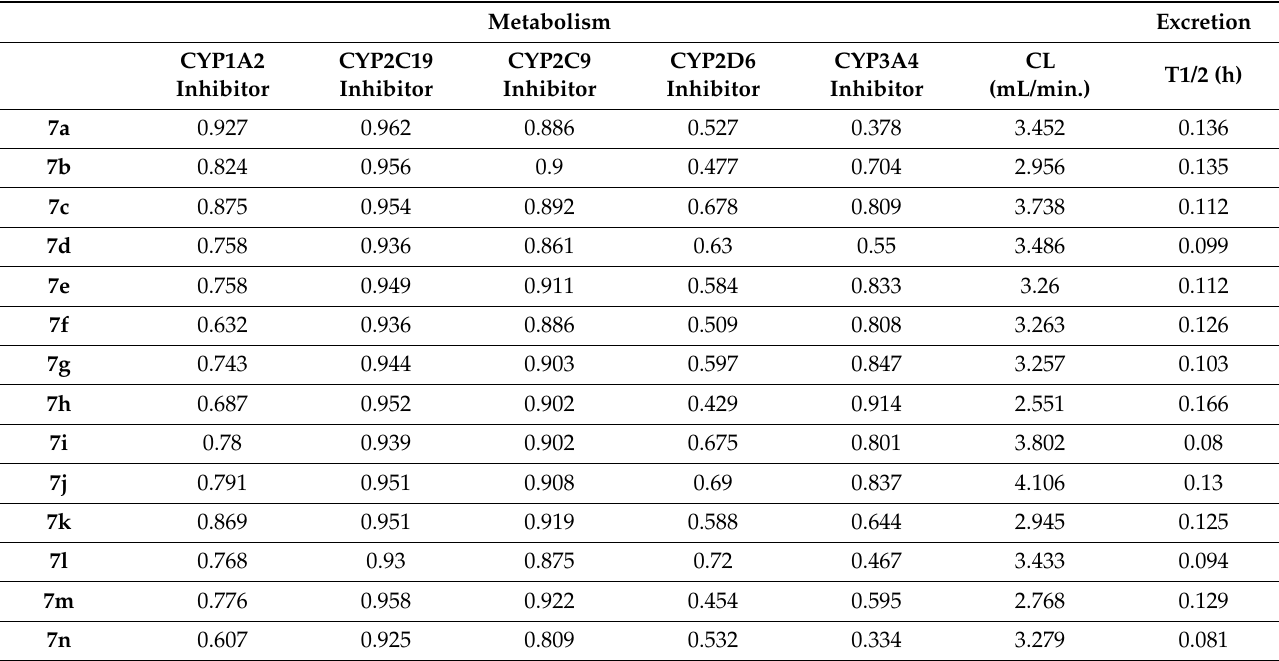
Table 8. Metabolism and Excretion values of selected compounds.